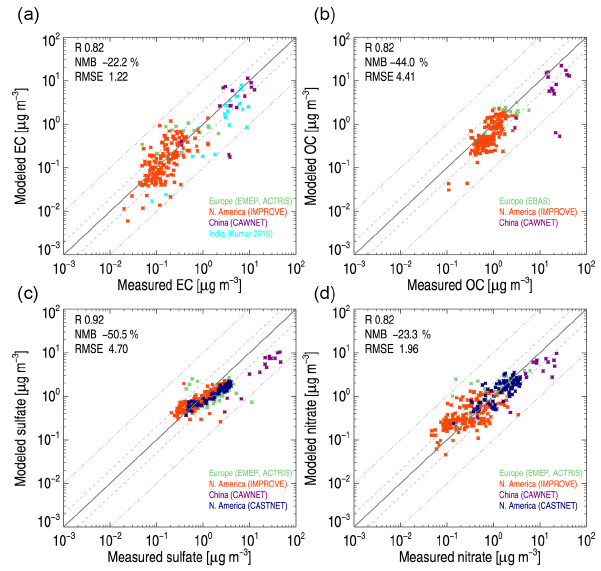
Figure 1. Annual mean modeled versus measured aerosol surface concentrations of (a) EC, (b) OC, (c) sulfate, and (d) nitrate from the IMPROVE, EMEP, ACTRIS, CASTNET, and CAWNET mea- surement